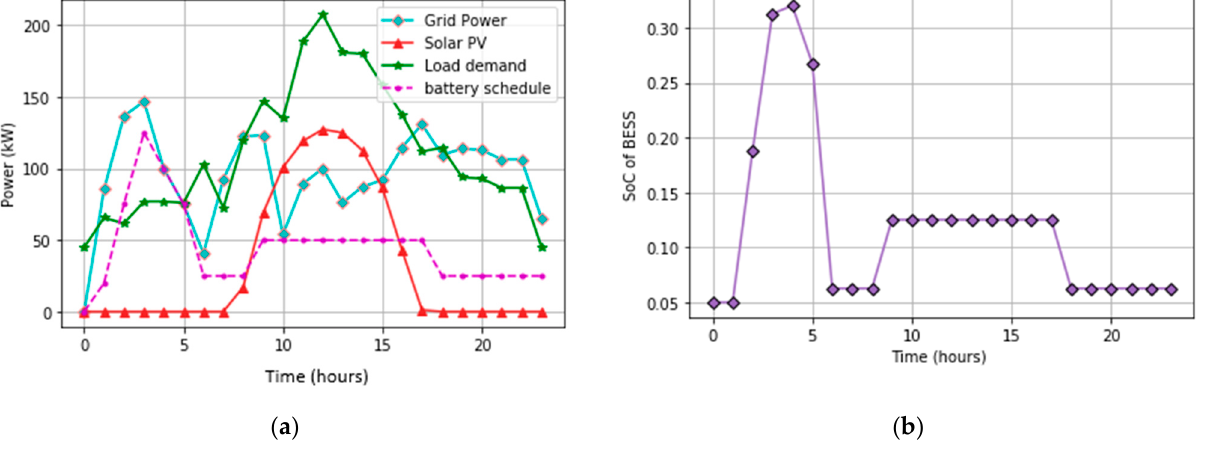
Figure 9. Observations with grid constraint; ( a ) Optimized energy schedule. ( b ) Tendency of the SoC of the BESS.